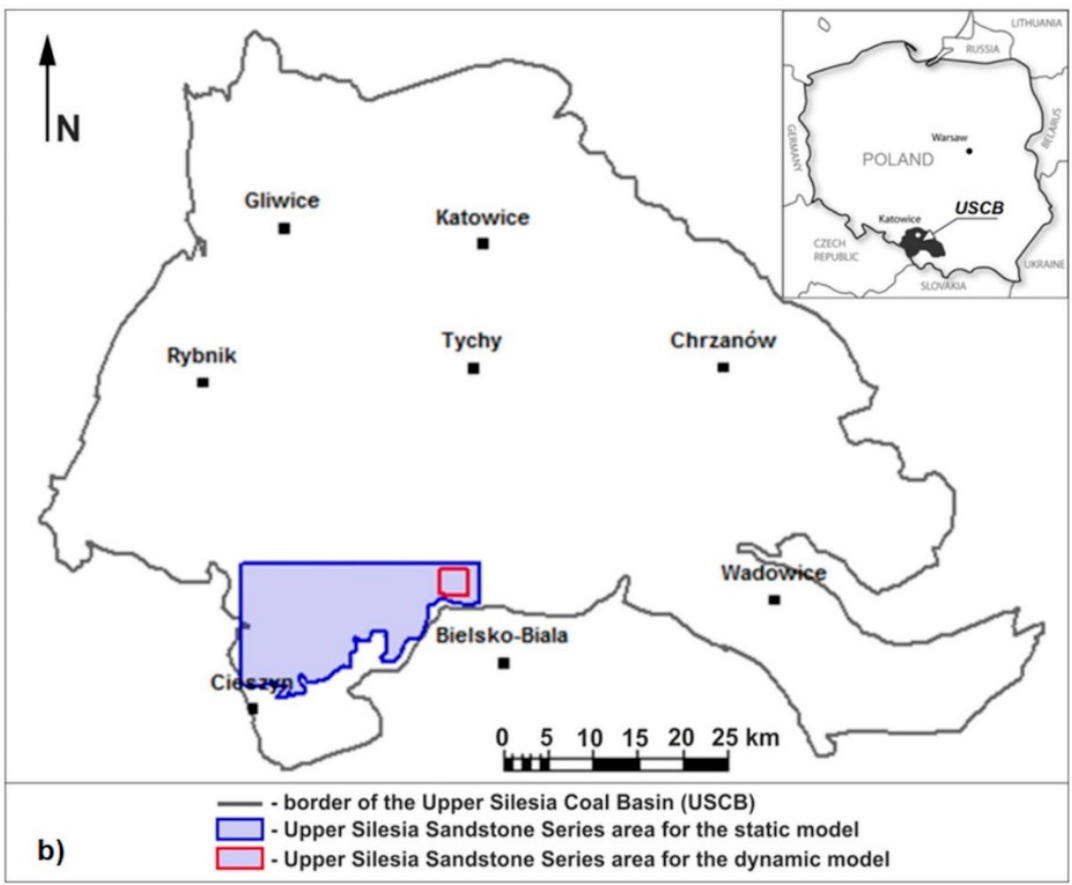
Figure 1. Location of static and dynamic models in the Cracow Sandstone Series and D˛ebowiec formation ( a ) and the Upper Silesian Sandstone Series ( b ).